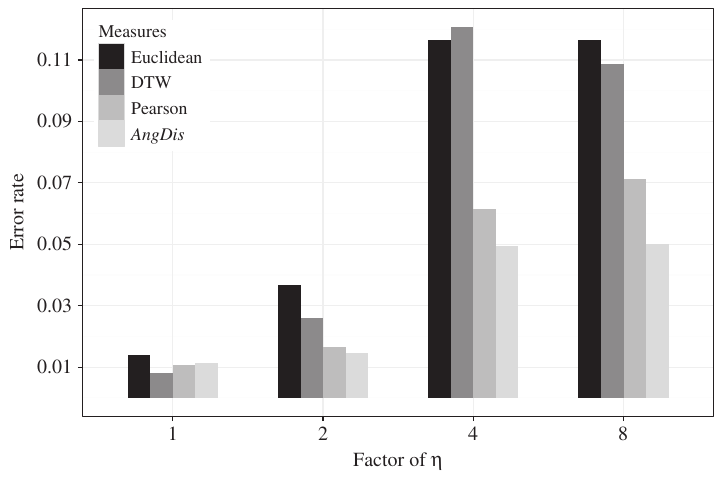
Figure 5. Experimental Results After Changing the Multiplier of η .